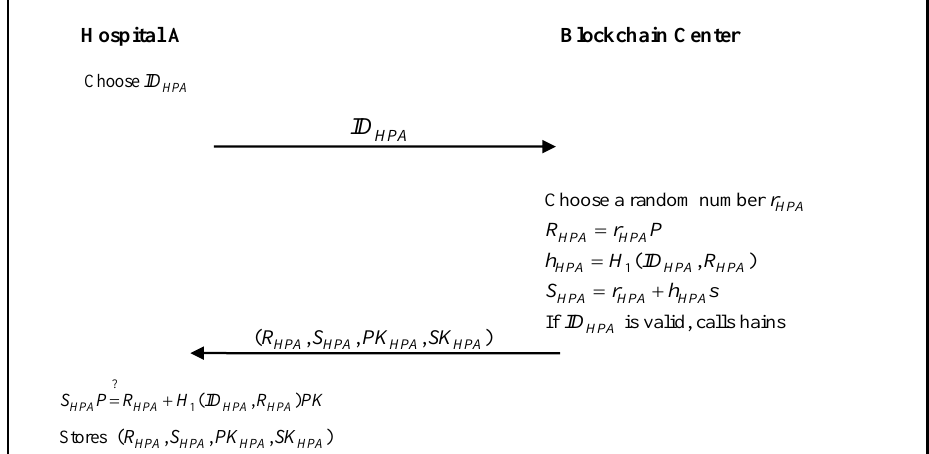
Figure 3. The hospital A registration phase of the proposed scheme.